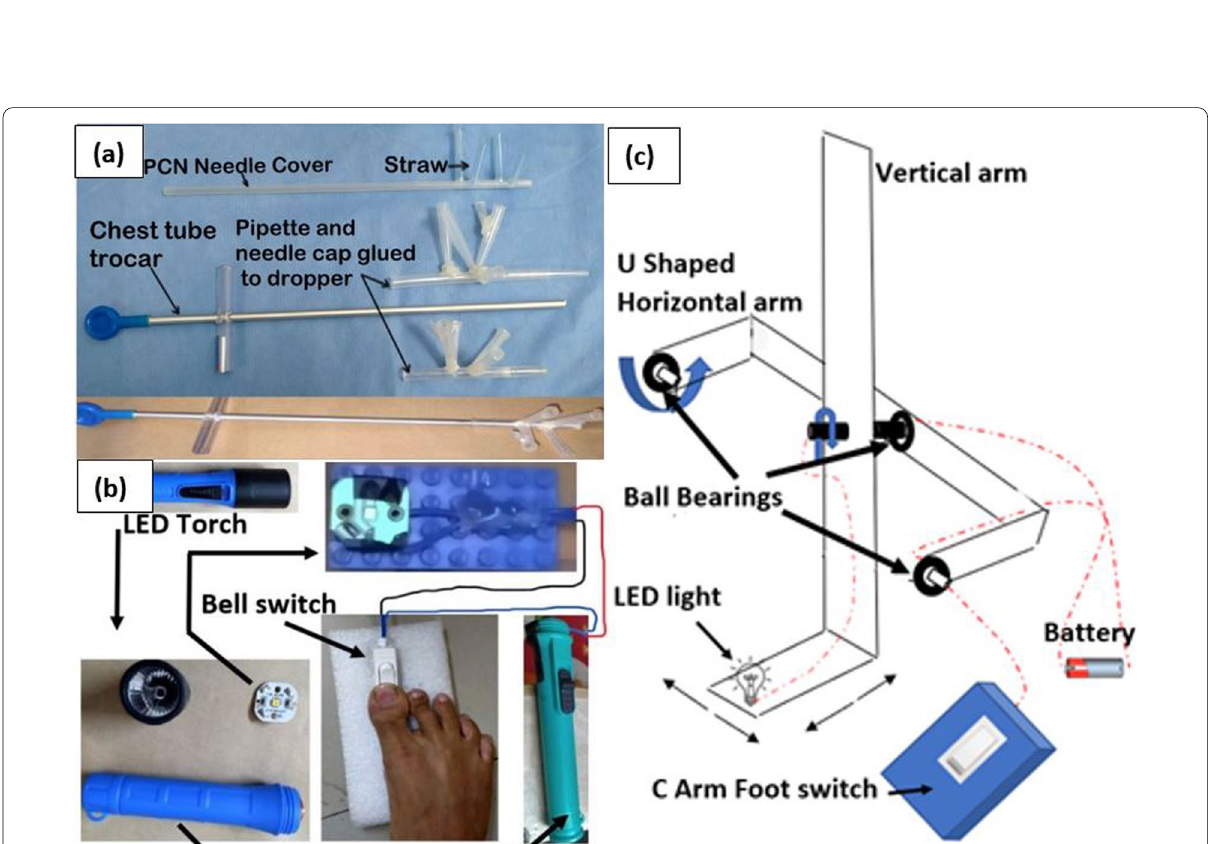
Fig. 3 a Calyceal replica b Making C-arm foot switch and light arm assembly source using LED torch c C-arm